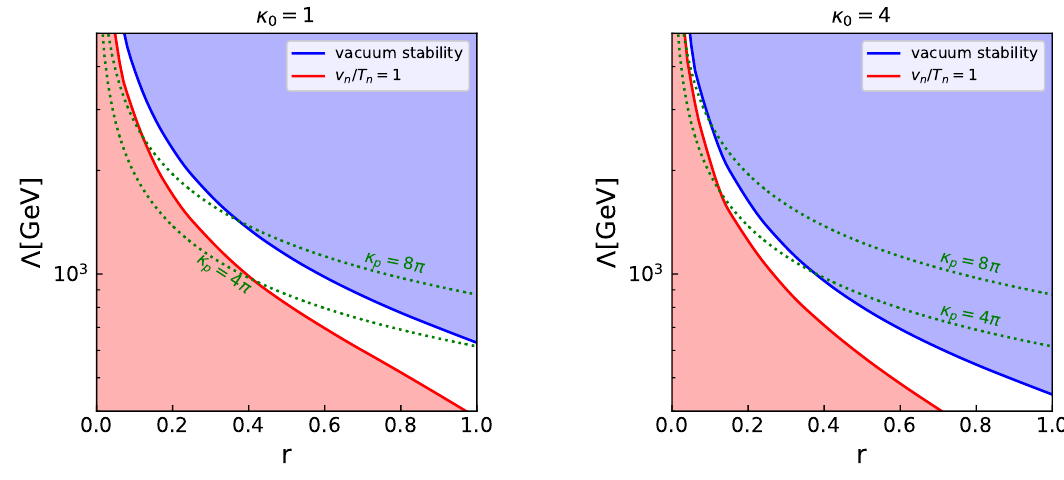
Figure 2 . The parameter region for the strongly first-order EWPT. The left and right figures correspond to the case with κ 0 = 1 and κ 0 = 4 , respectively. The strongly first-order EWPT can be realized in the white region. v n /T n < 1 or the first-order EWPT cannot be realized in the red region. The blue region is excluded by the vacuum stability which is estimated in ref.